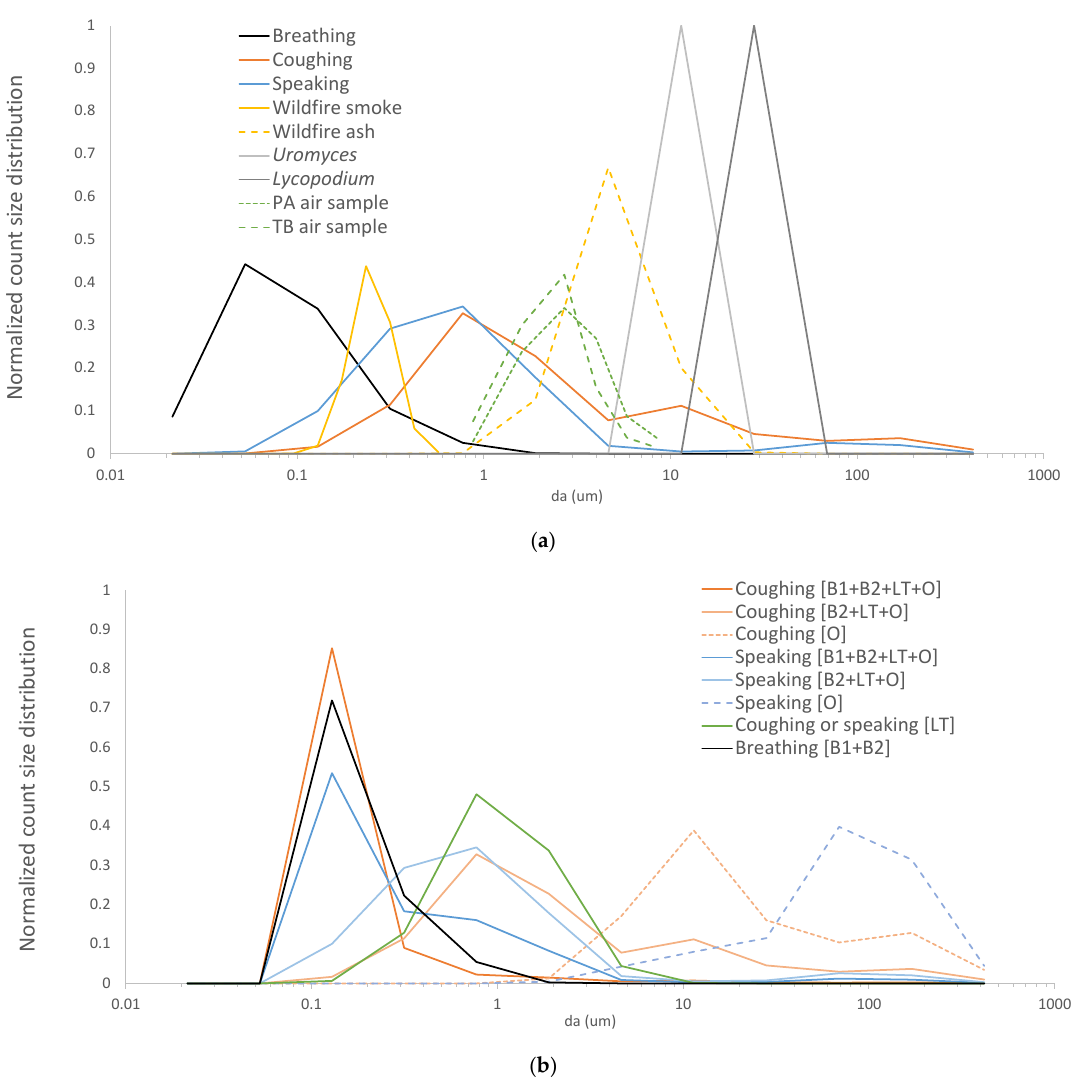
Figure 1. Modeled lognormal size distribution modes for: ( a ) allergenic bioaerosols (pollen grains and moss spores), human-emitted particles (coughs, speaking, and breathing), and wildfire-emitted particles (smoke and ash); and ( b ) infectious SARS-CoV-2 virion distributions generated at various organ locations. Also shown in ( a ) are data adapted from measured airborne Mycobacterium tuberculosis (TB) [49] and Pseudomonas aeruginosa (PA) [50]. All distributions were discretized and evaluated at 12 size bins spanning da = 0.02–420 μ m.